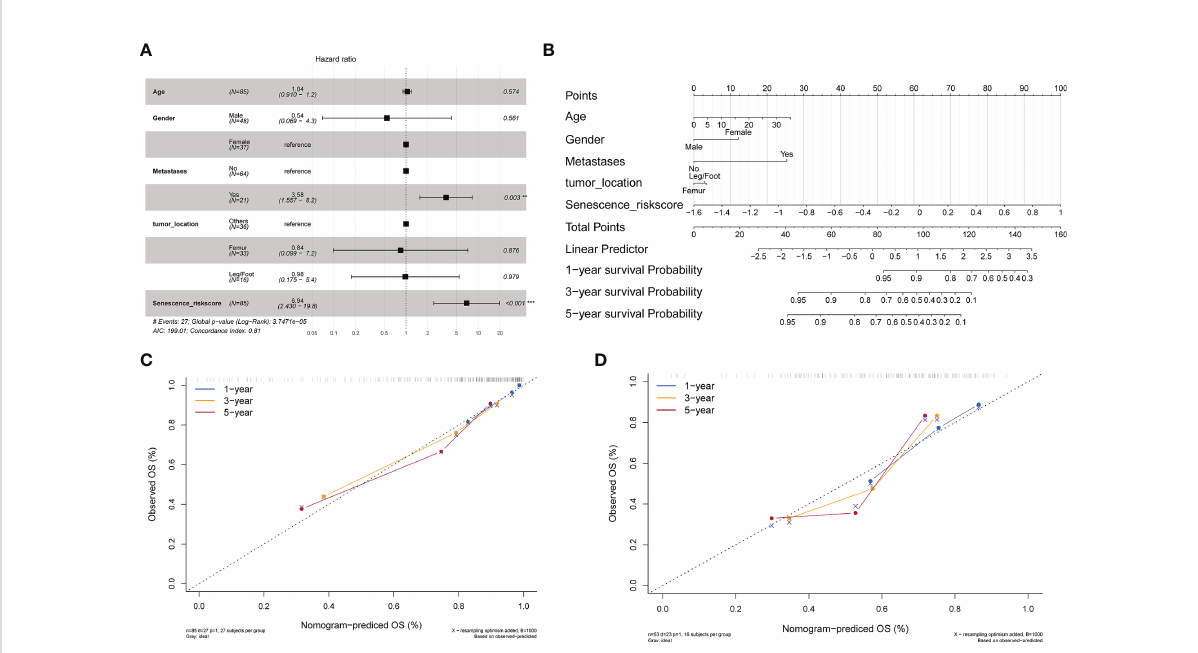
FIGURE 4 Development of a nomogram integrating clinical information. (A) Multivariate Cox analysis integrating clinical information and the risk score. (B) Nomogram for evaluating the 1- to 5-year overall survival of osteosarcoma patients. (C) Nomogram calibration for the training cohort (TARGET- OS) over 1 – 5 years. (D) Nomogram calibration for the veri fi cation cohort (GSE21257) over 1 – 5